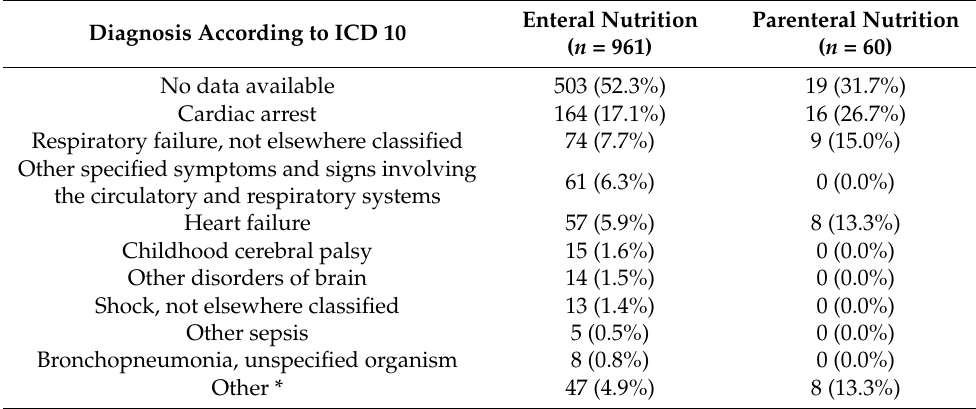
Table 5. Causes of in-hospital deaths for HEN and HPN patients within 365 days of service provision completion.